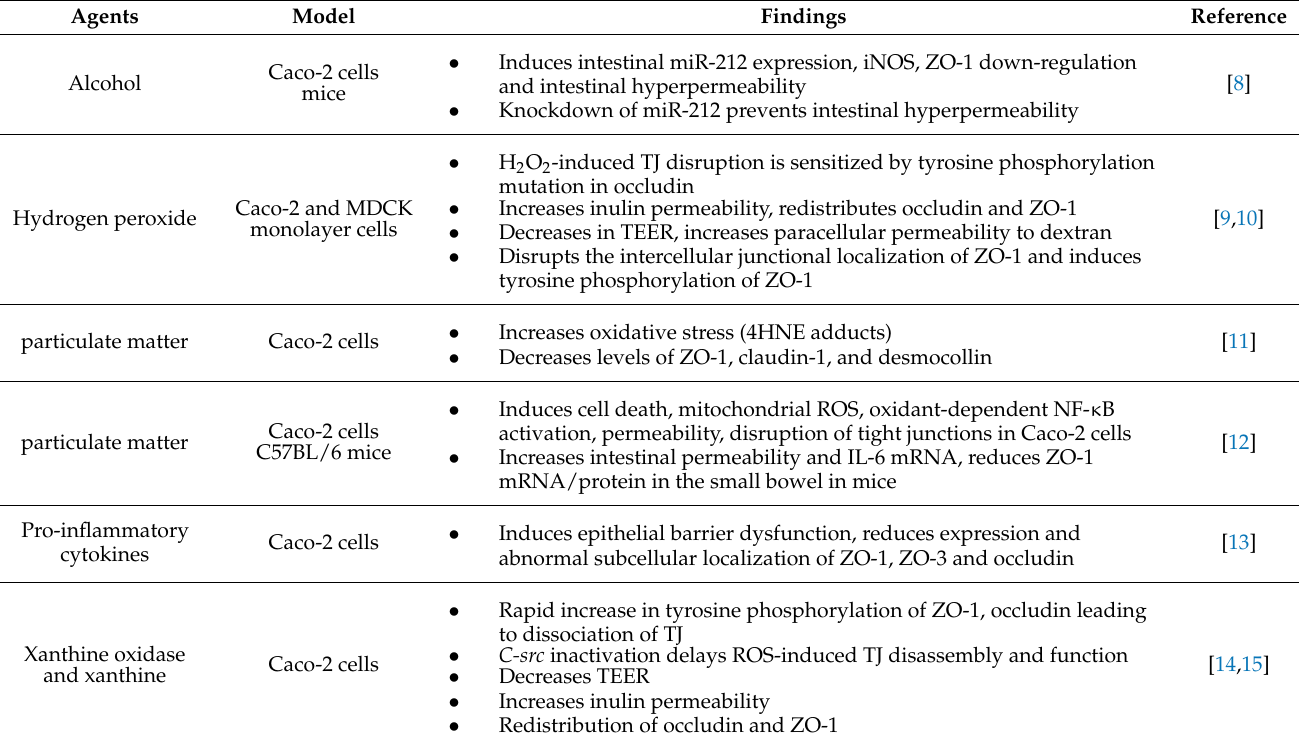
Table 1. Examples of factors that disrupt the intestinal